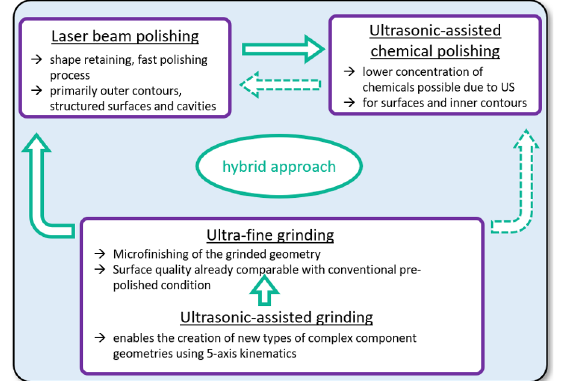
Fig. 1. schematic representation of the novel process chain